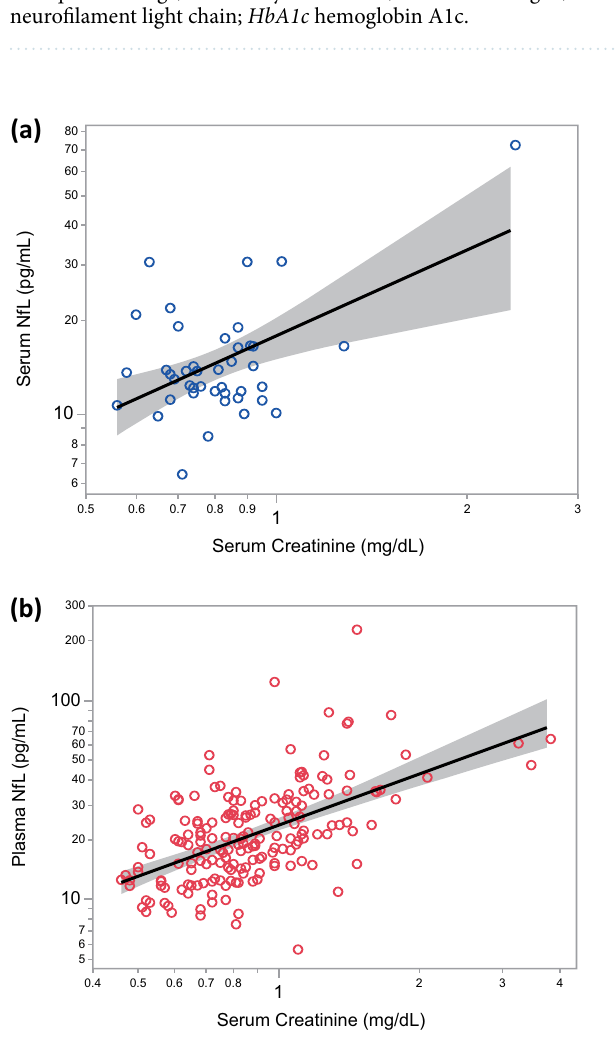
Figure 1. A positive correlation between blood NfL and serum creatinine levels in the HC group ( a ) and the DM group ( b ). NfL: neurofilament light